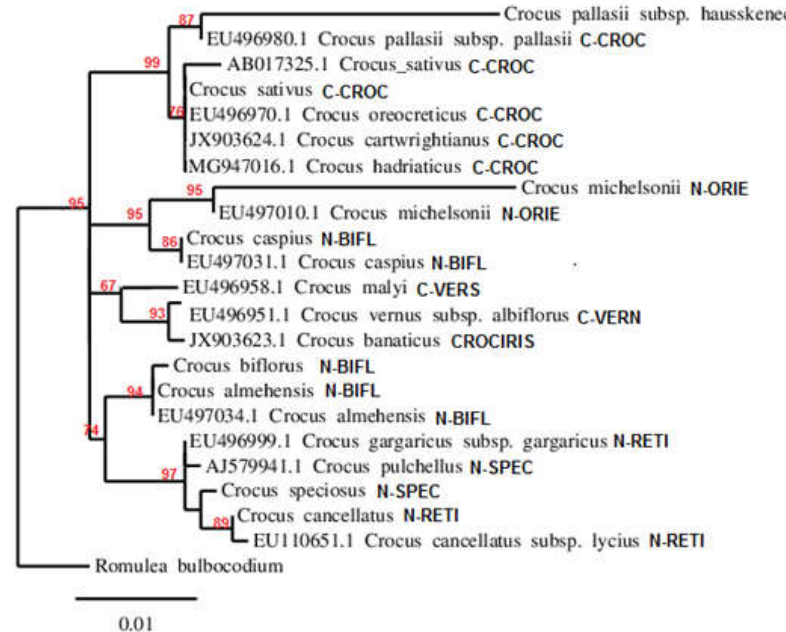
Fig. 5. The phylogenic tree derived from the analysis of mat K+ rbc L region data by the Bayesian method, the number above each branch shows the bootstrap value.